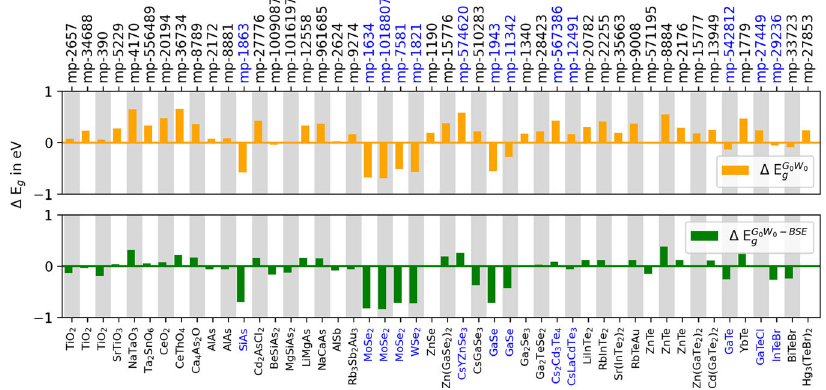
Fig. 1 Differences between E HSE and E G 0 W 0 (orange) as well as E G 0 W 0 (cid:1) BSE (green). The chemical formula and Materials Project id ’ s (mp-id) for g g g each material are shown on the bottom and top x -axis ticks respectively. The layered materials have been labeled in